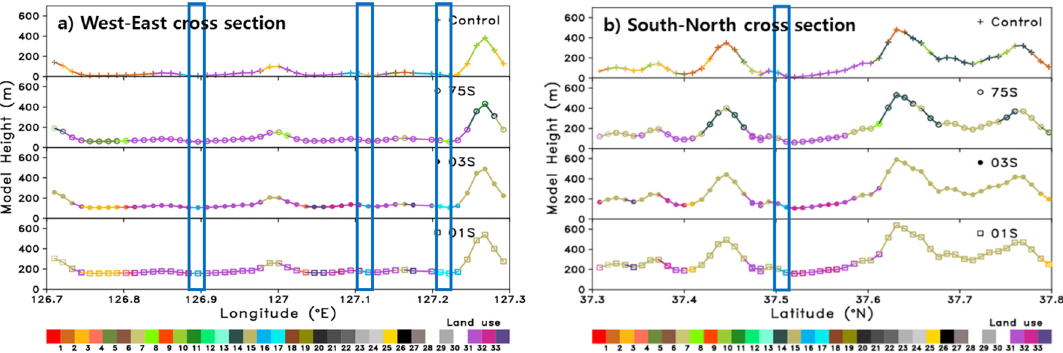
Figure 4. Topographical database for east–west and south–north cross sections shown in Figure 1d. The x-axis is ( a ) longitude and ( b ) latitude. The y-axis is surface height in meter. The colorbar indicates the type of land use. Vertical blue boxes represent locations of the Han River.